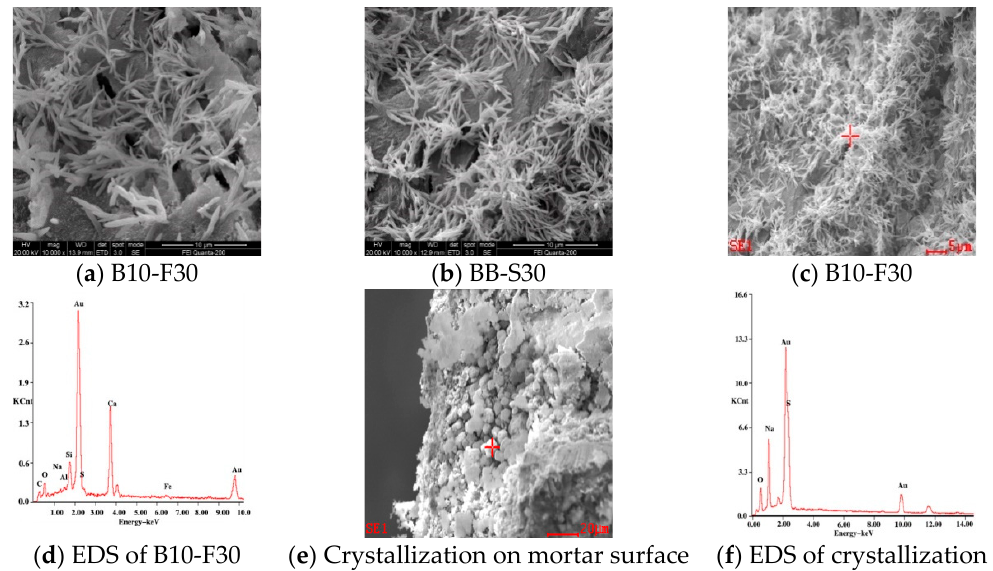
Figure 15. ESEM-EDS spectra of mortar containing different admixtures attacked by different erosion forms.